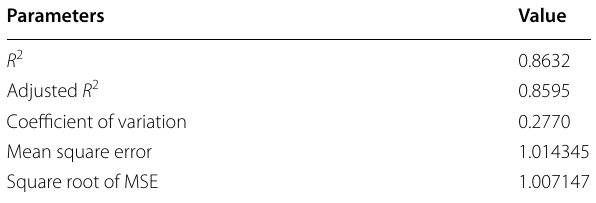
Table 1 Statistical parameters of multiple regression for model